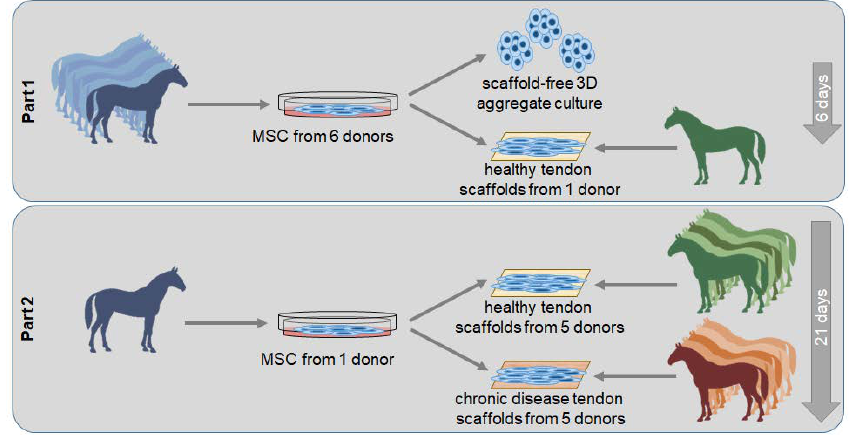
Figure 8. Overview of the experimental